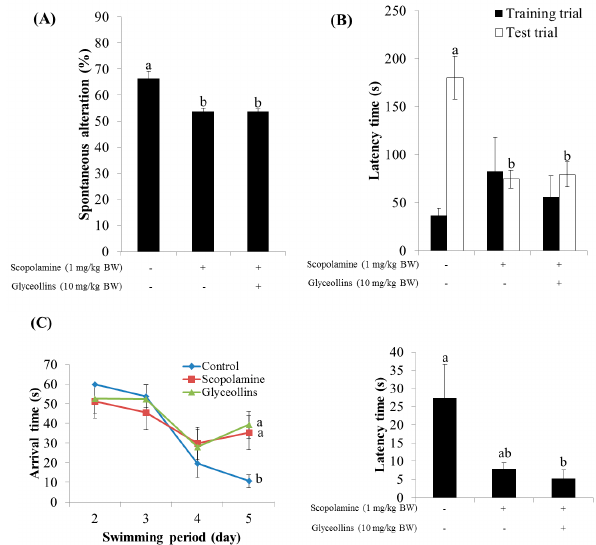
Figure 7. Effect of glyceollins on cognitive function in Nrf2 knockout mice. Nrf2 knockout C57BL/6 mice (five weeks old, n = 7) were pretreated with glyceollins (10 mg/kg bw) 24 h before cognitive function or behavior tests, and then subjected to Y-maze ( A ); passive avoidance ( B ); and Morris Water maze ( C ) tests after injected i.p . with scopolamine (1 mg/kg bw). Different alphabetical letters (a, b) on bars indicate statistically significant differences.